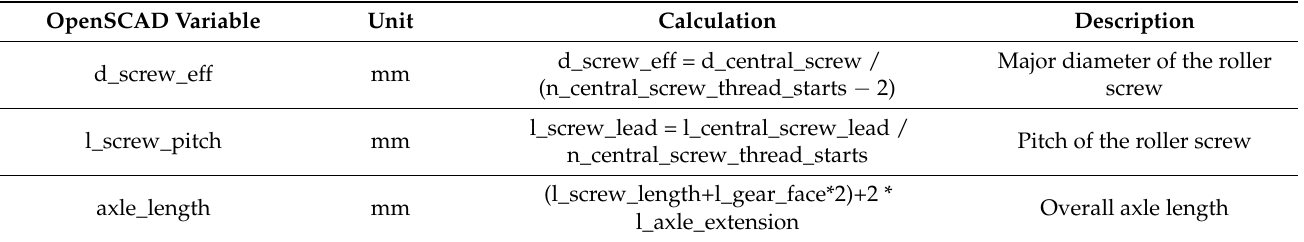
Table A5. OpenSCAD variable and calculation for roller.